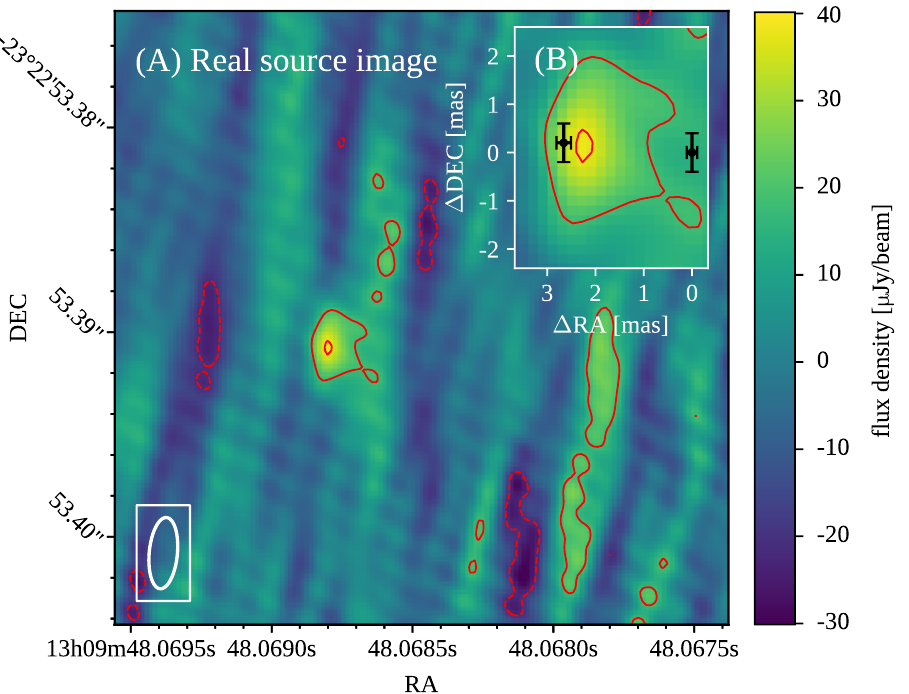
Figure 13. Global VLBI image of the GRB170817A afterglow 207 days after the merger. The main panel ( A ) shows the cleaned surface brightness map (color-coded according to the color bar on the right) of a small region around the position of GW170817, observed 207 days after the merger. Red contours are lines of constant surface brightness corresponding to − 20 (dashed), 20 and 40 (solid) µ Jy/beam. The root-mean-square of the image noise is 8 µ Jy/beam. The ellipse in the lower left corner of the plot encompasses the full width at half the maximum of the synthesized beam (i.e., the resolution element). The inset, panel ( B ), shows a zoom of the region close to the peak of the surface brightness distribution, with black error bars marking the best fit and one-sigma errors on the centroid position of the source at 75 and 230 days, as measured by [66], with the axes showing the displacement with respect to the position at 75 d. Reproduced from